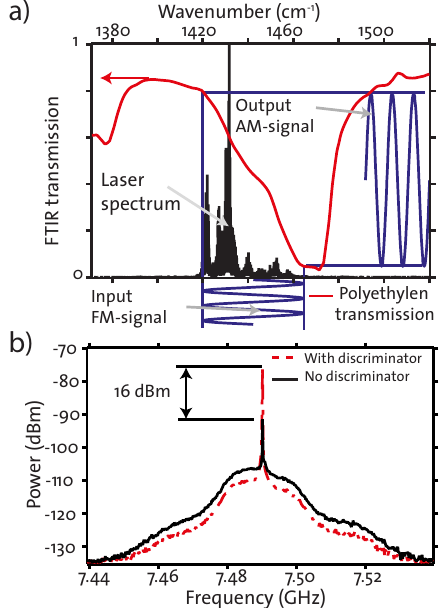
Figure 9: Frequency-modulated QCL comb. a Optical spectrum (black) as well as polyethylen transmission spectrum (red) acting as an optical discriminator. b RF spectrum showing the beatnote at the round trip frequency. An increase of the RF beatnote, character- istics of an FM to AM